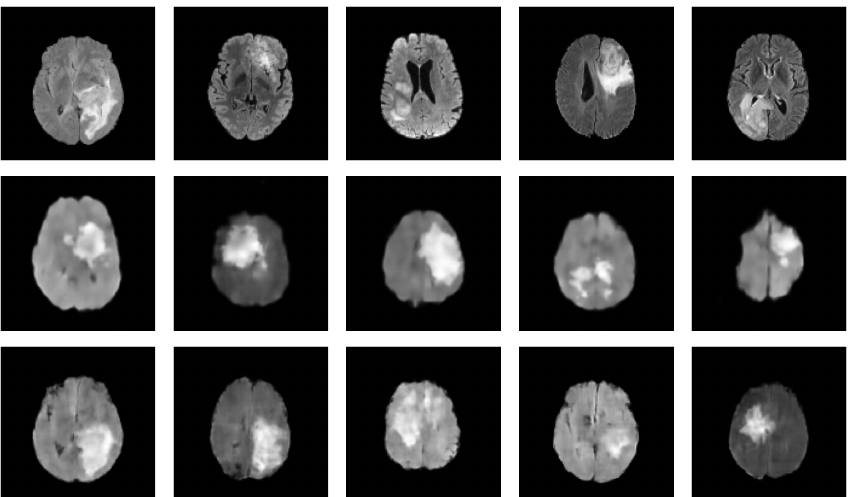
Figure 6. Figure presenting a comparison between synthesized MRIs generated by a VAE and a Hamiltonian VAE [159]. Both models were trained on a limited training set of 100 images from BraTS2020 Challenge dataset. The first row showcases original images, while the second and third rows present synthesized images generated by the VAE and Hamiltonian VAE, respectively. While the images generated by both models appear slightly fuzzy, the Hamiltonian VAE demonstrates enhanced performance in generating realistic images. This comparison highlights the robustness of the VAE and Hamiltonian VAE for generating new images from a small dataset